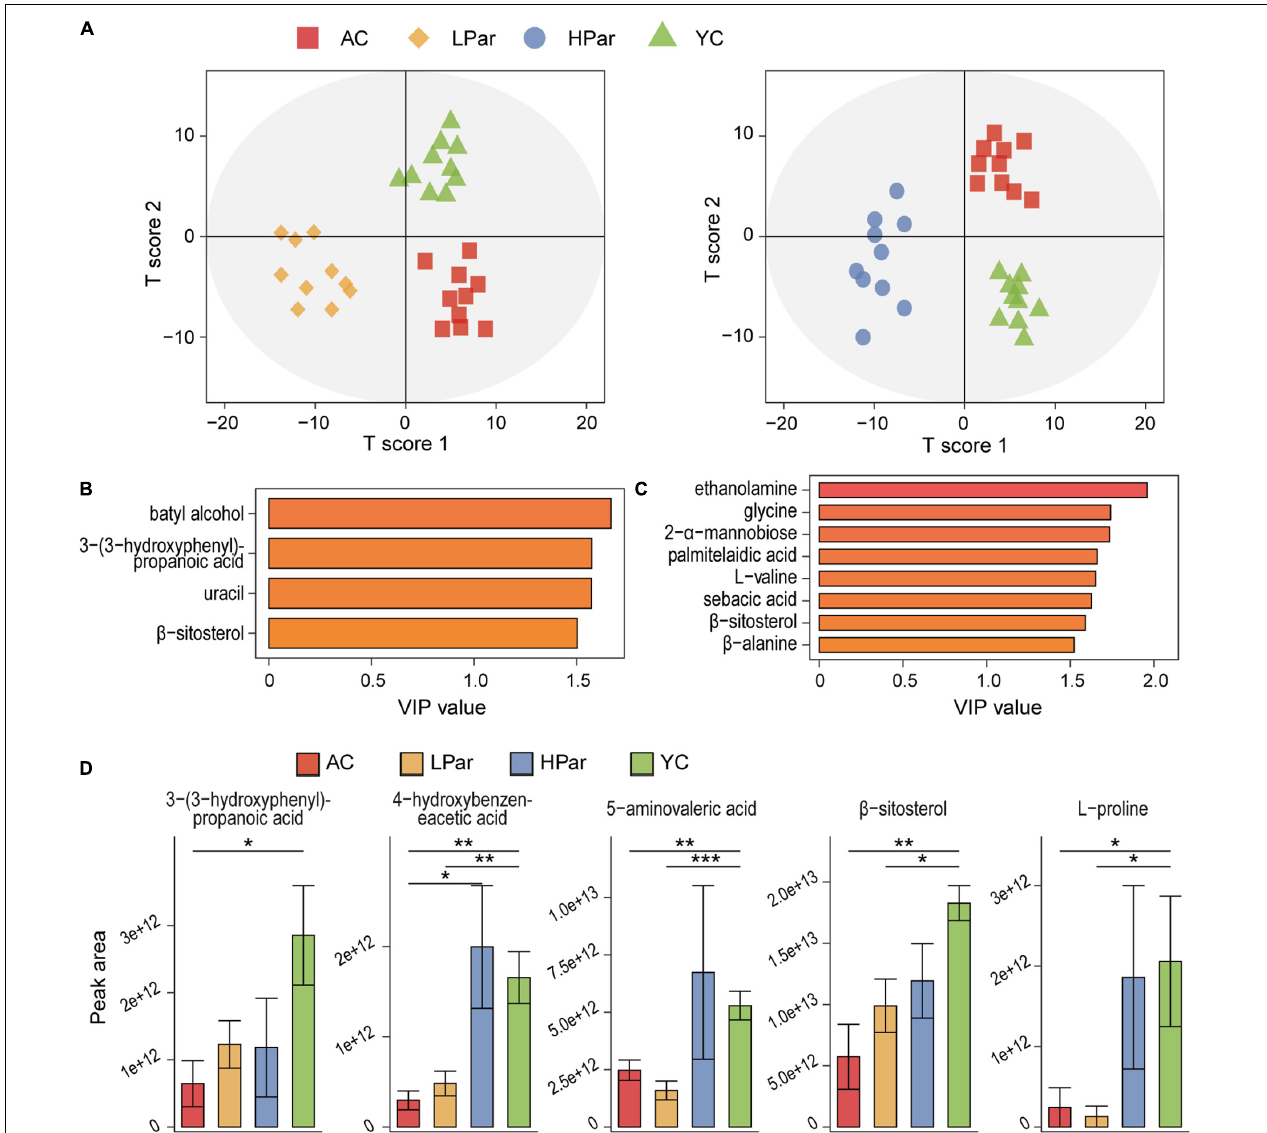
FIGURE 5 | Parishin alleviates aging-induced gut metabolic disorder. (A) OPLS-DA plot illustrating clear separation of gut metabolic profiles of the AC, LPar and YC groups, and the AC, HPar and YC groups. (B) VIP values of 4 metabolites with the highest contribution to the separation of the AC, LPar and YC groups in the OPLS-DA model. (C) VIP values of 8 metabolites with the highest contribution to the separation of the AC, HPar and YC groups in the OPLS-DA model. (D) Levels of five differentially distributed metabolites in the four groups. * P < 0.05; ** P < 0.01; *** P <